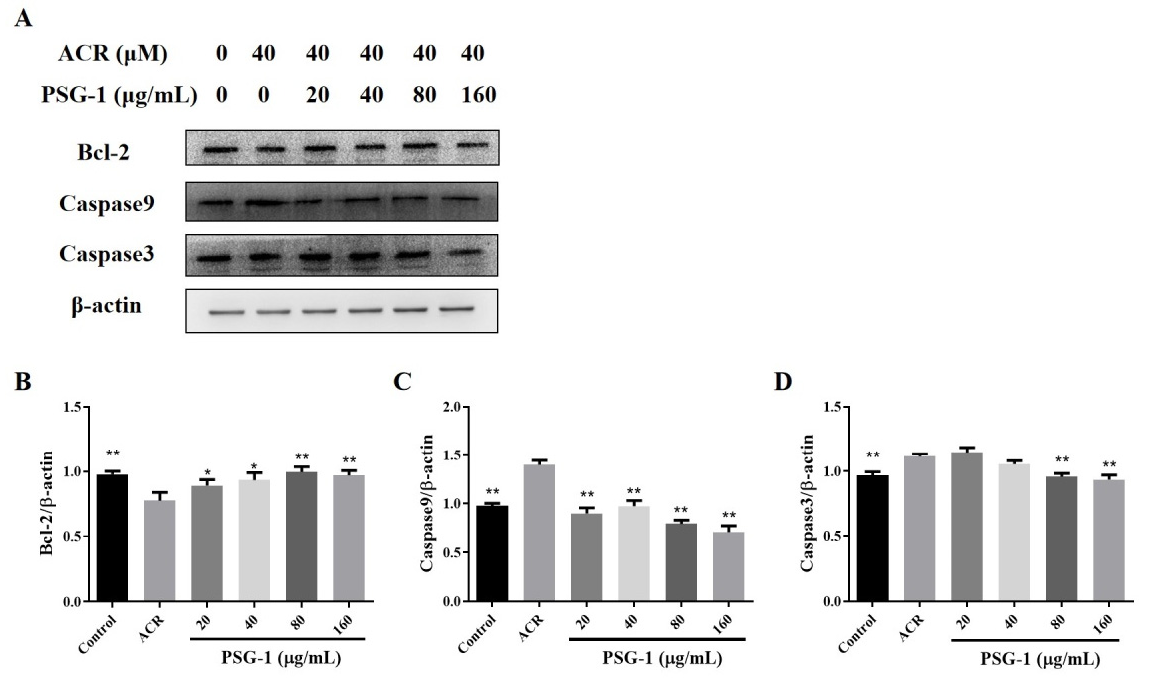
Figure 7. PSG-1 regulated the expression of apoptosis-related proteins in acrolein-induced IEC-6 cells. ( A ) The protein levels of caspase-9, caspase-3, and Bcl-2. ( B – D ) Relative intensities of these proteins. Values are means ± SD ( n = 3), * p < 0.05, ** p < 0.01 compared with the acrolein group. 3.8. Effects of Autophagy Inhibitor and Apoptosis Inhibitor on the TJ in IEC-6 Cells